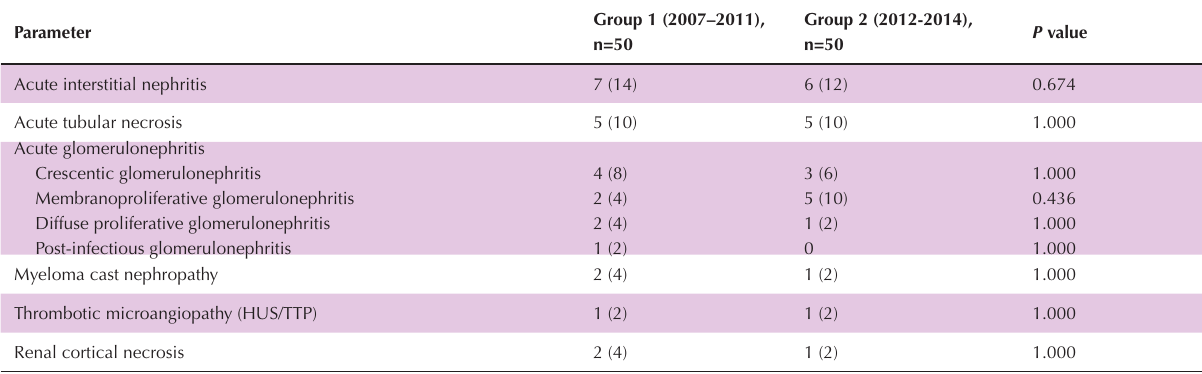
Table 3. Summary of renal